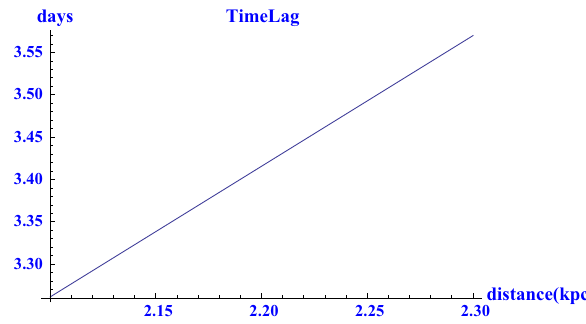
Fig. 1 The Shapiro delay due to the dark matter potential along the line of sight as a function of distance in the vicinity of the Crab